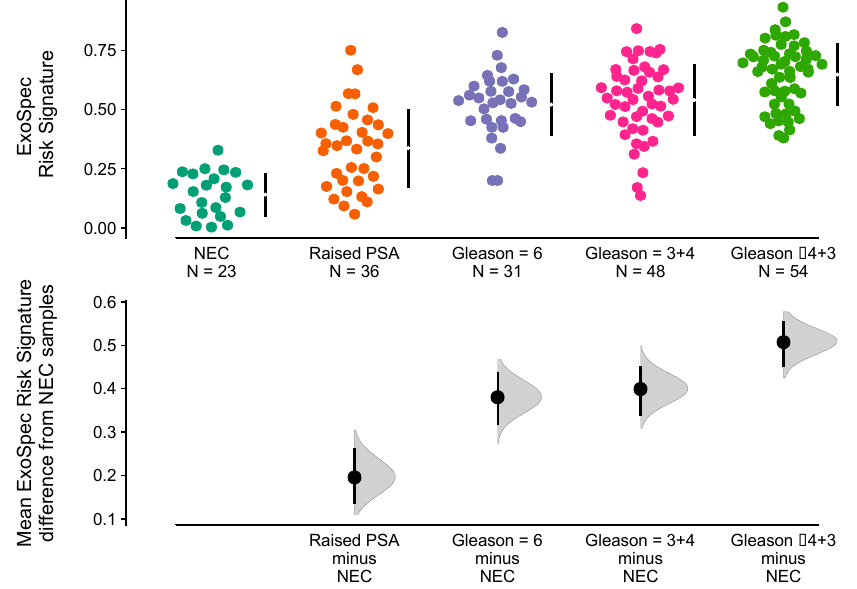
Figure 3. Relationship between ExoSpec risk signature score and biopsy status using Cumming estimation plots. In the top panel, each point displays the ExoSpec risk score for a sample stratified by biopsy status across the x-axis. Each sample point is coloured according to their biopsy Gleason score or ‘No Cancer’ status: NEC—No evidence of cancer, Raised PSA—Raised PSA with negative biopsy. Mean and standard deviation ExoSpec risk signature score distributions for each group are shown by a gapped vertical line. The bottom panel shows mean differences in ExoSpec signatures relative to NEC patient samples. Calculated from bias-corrected and accelerate bootstrap resampling (1000 resamples with replacement), sample density distributions are presented with a point estimate and vertical bar to show mean difference and 95% confidence intervals, respectively.